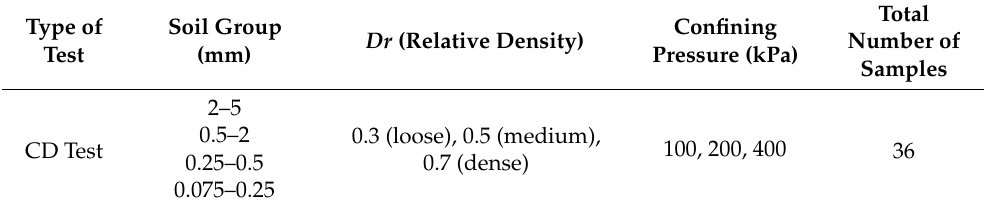
Table 3. Triaxial shear test scheme for four particle size